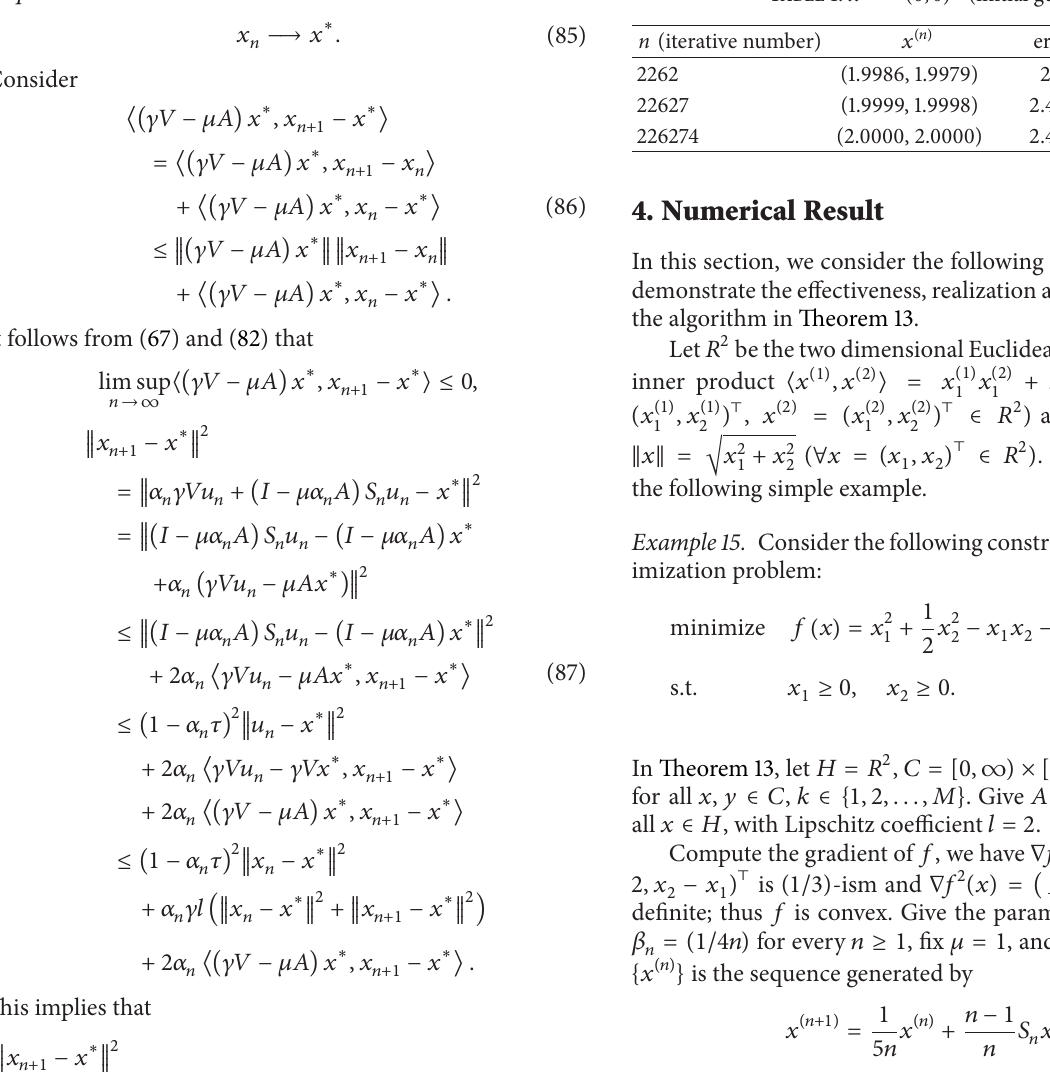
Table 1: 𝑥 (1) = (0,0) ⊤ (initial